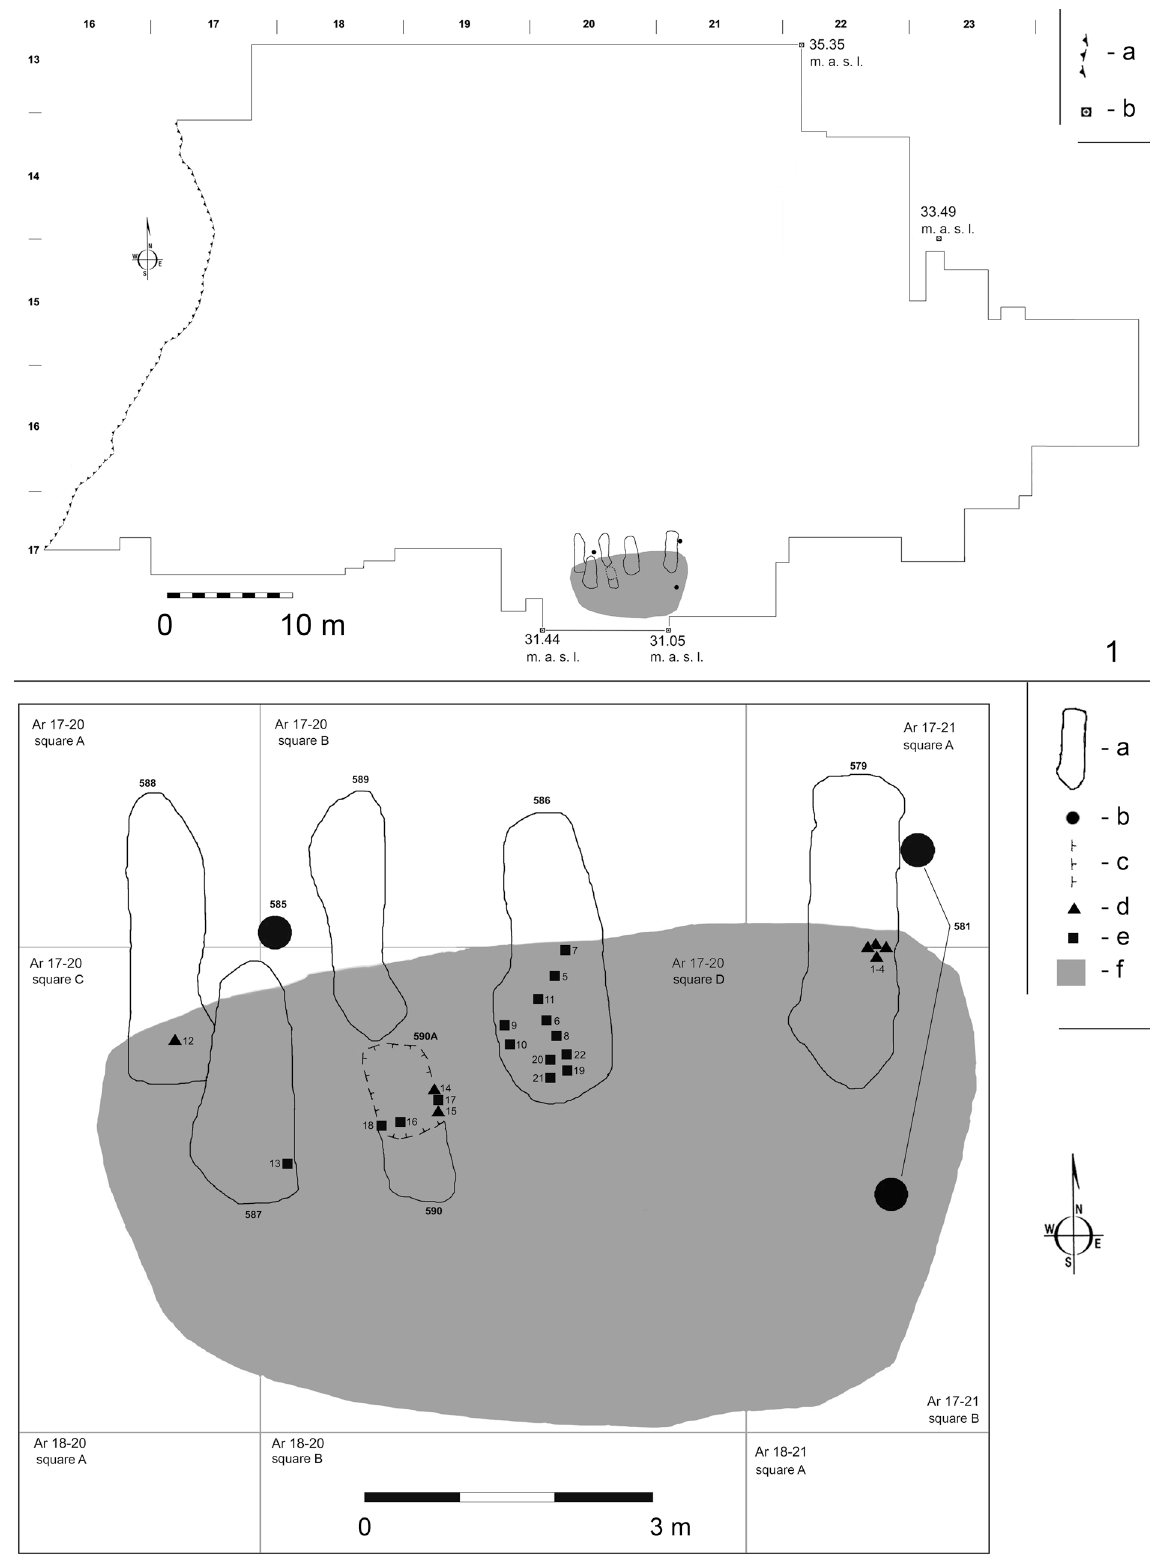
Figure 5. Weklice, Elbląg Count y. 1. the excavated fragment of the site; the locations of flint artefacts found on the site are marked: a. gravel mine face; b. geodesic benchmarks; 2. flint artefacts scatter within graves and features of the Wielbark culture and the conjectured boundary of the occupation layer [100A-B ]: a. Wielbark culture inhumation graves; b. Wielbark culture urn cremation graves; c. feature 590A (ancient robbery trench leading to grave 590); d. flints found in the grave fill; e. flints found in layer [100B] below the grave-pit bottom; f. conjectured boundary of the occupation layer [100A-B ]. (Drawing by M. Natuniewicz- Sekuła.